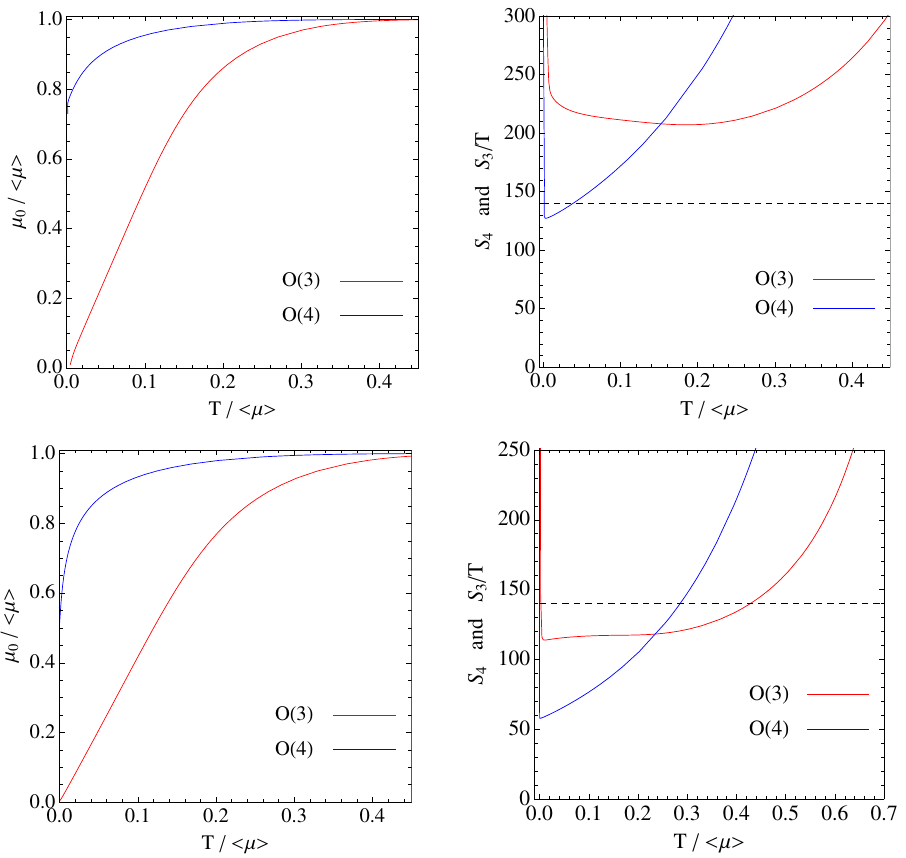
Figure 5 . Upper panels: as in (cid:12)gure 4 but for scenario B 8 . Lower panels: as in (cid:12)gure 4 but for scenario B 2 . The (cid:12)ndings are qualitatively similar to those arising in the most common parameter scenarios where the back-reaction is large (cf. (cid:12)gure